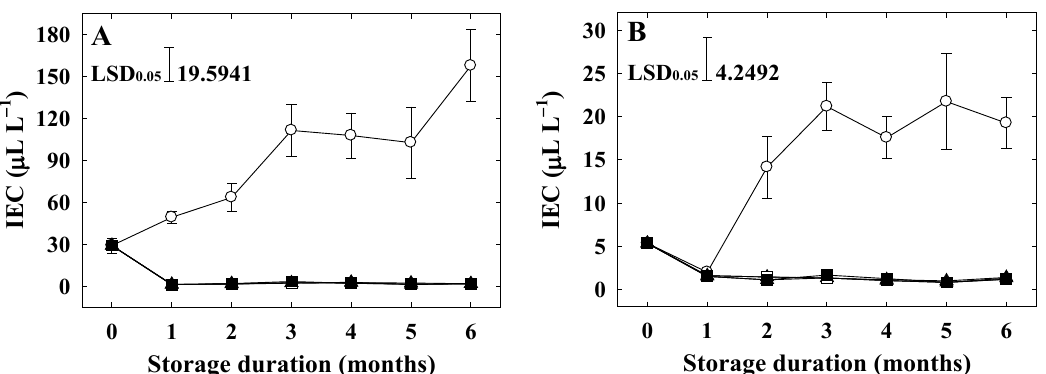
Figure 2. Internal ethylene content (IEC) of ‘Arisoo’ ( A ) and ‘Picnic’ ( B ) apples during cold storage at 0 ± 1 °C with 90–95% relative humidity for up to six months. Fruits were treated with 0.5 μL L −1 1- MCP (∆) and 1 μL L −1 1-MCP ( ▲ ) at harvest, and 0.5 + 0.5 μL L −1 1- MCP (□) a nd 1 + 1 μL L −1 1-MCP ( ■ ) at harvest and 2 months after storage, and untreated as control ( ○ ). Data are presented as mean ± standard error ( n = 15).